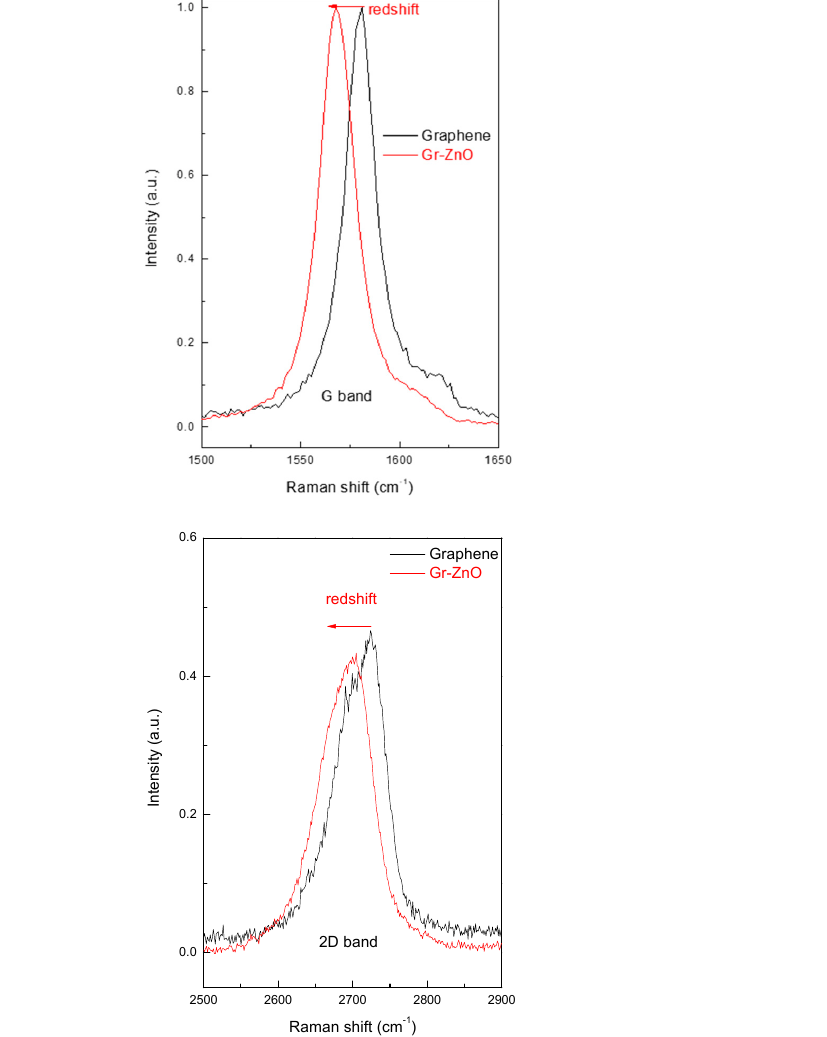
Figure 12. The shift of G and 2D bands in the Raman spectrum of graphene functionalized with ZnO nanoparticles in comparison with that of pristine graphene.